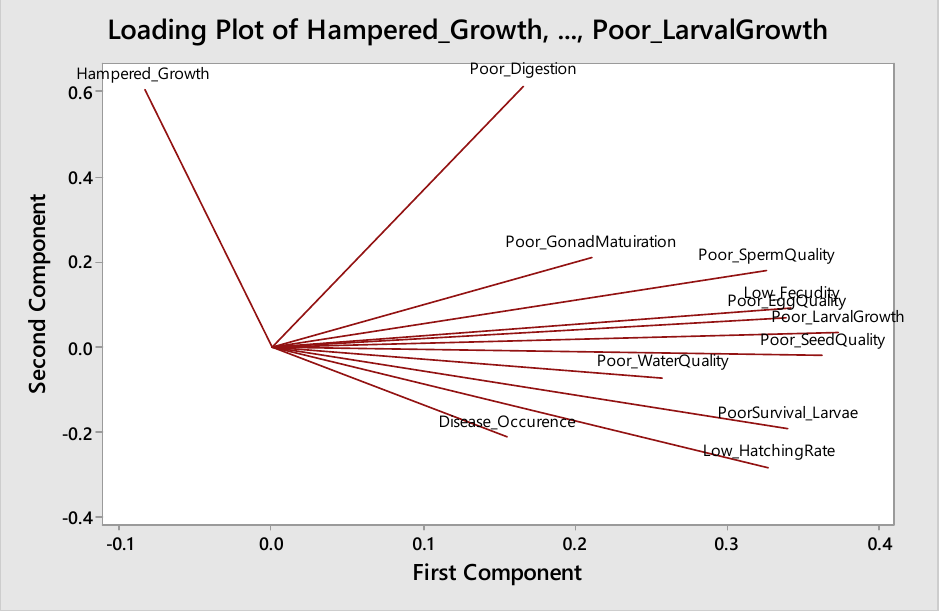
Figure 3. Loading plot corresponding to the top two principal components.